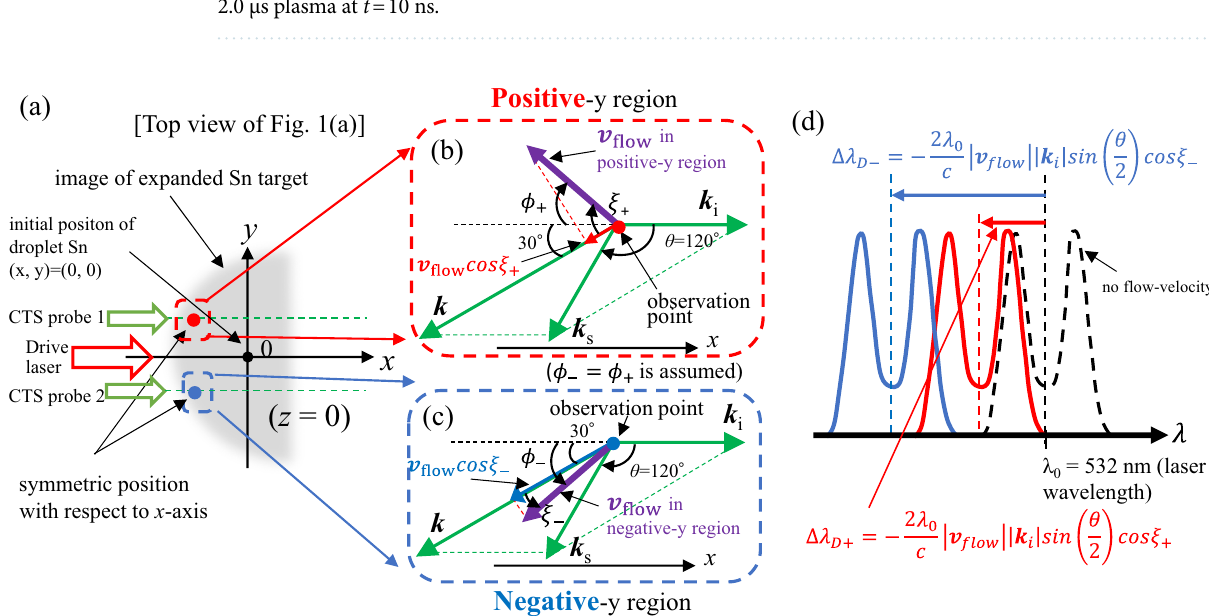
Figure 9. ( a ) Explanation of negative-y and positive-y regions using top view of Fig. 1a. ( b ), ( c ) Vector diagram at positive-y and negative-y regions, respectively. ( d ) Image of spectral shift due to Doppler shift at positive-y and negative-y